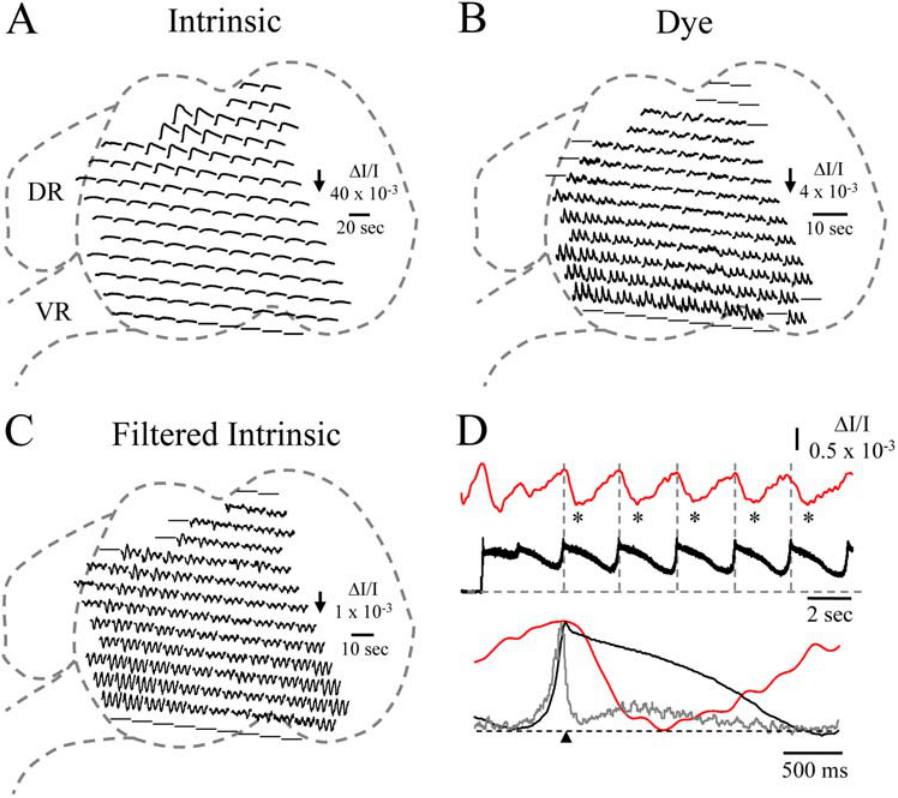
Figure 3. Comparison of the spatial distribution of two kinds of intrinsic signal and dye-related signals recorded from the cut, transverse face of the spinal cord. A–C. Distribution of intrinsic (A), dye-related (B) and filtered intrinsic (C) signals during an episode of rhythmic activity. The signals in A and C were obtained in an unstained slice which was subsequently stained with the voltage sensitive dye NK2671 to provide the VSD signals shown in B. The data were acquired at an interval of 0.42 ms. The signals in A were unfiltered and those in B were low pass filtered at 100Hz. The signals shown in D were obtained by bandpass (0.1–10 Hz) filtering the signals in A. Data in A is from a complete episode, while the signals shown in B and C were from 3 cycles from within the episode. Note that the dye signals and the filtered intrinsic signals exhibit a similar distribution of rhythmicity with the highest amplitude in the ventrolateral part of the cord. DR-dorsal root; VR-ventral root. D. The upper two traces compare the time course of the slow electrical activity (black trace) with the intrinsic optical signal recorded over the lateral motor column (red trace). Note that the peak of the optical signal is delayed with respect to the peak of the slow electrical signal. The lower traces are the cycle-averaged electrical (grey-integrated neurogram; black-low pass filtered slow potential) and optical (red-lateral motor column optical signal) responses generated from the cycles identified by the asterisks. The average was triggered from the peak of the slow potential as indicated by the vertical dotted grey lines. Data obtained from an E11